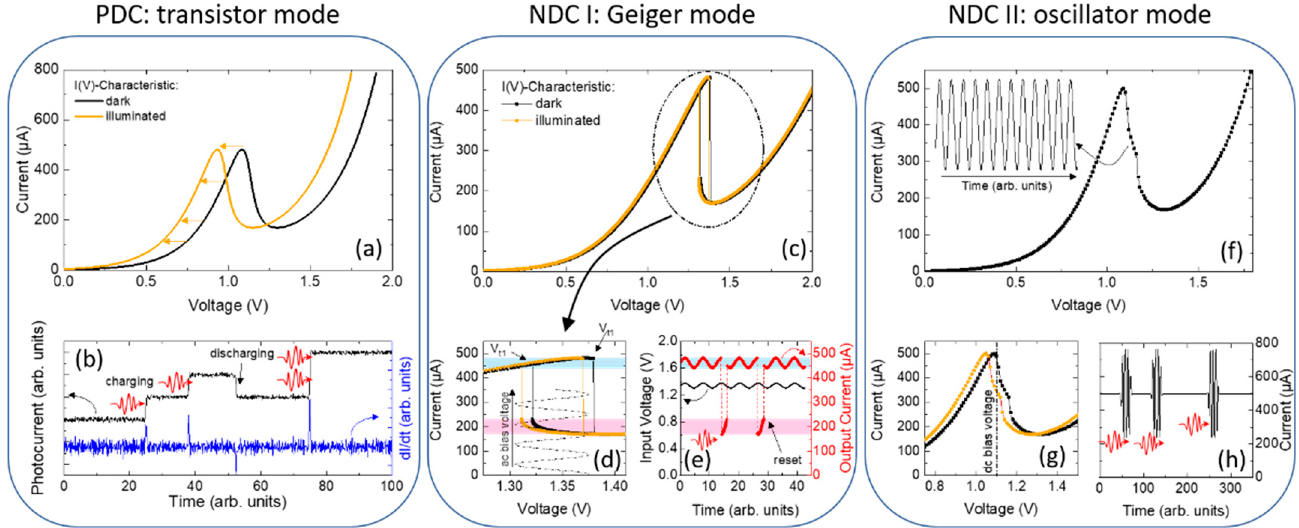
Figure 2. Operational modes of RTD-PDs. ( a , b ) PDC: transistor mode. ( c – e ) NDC I: Geiger mode. ( f – h ) NDC II: oscillator mode. All operational modes rely on the accumulation of photogenerated minority charge carriers in the vicinity of the DBQW. Due to the additional voltage drop, the current–voltage characteristics are shifted to lower voltages. In PDC: transistor mode, the RTD-SPD is